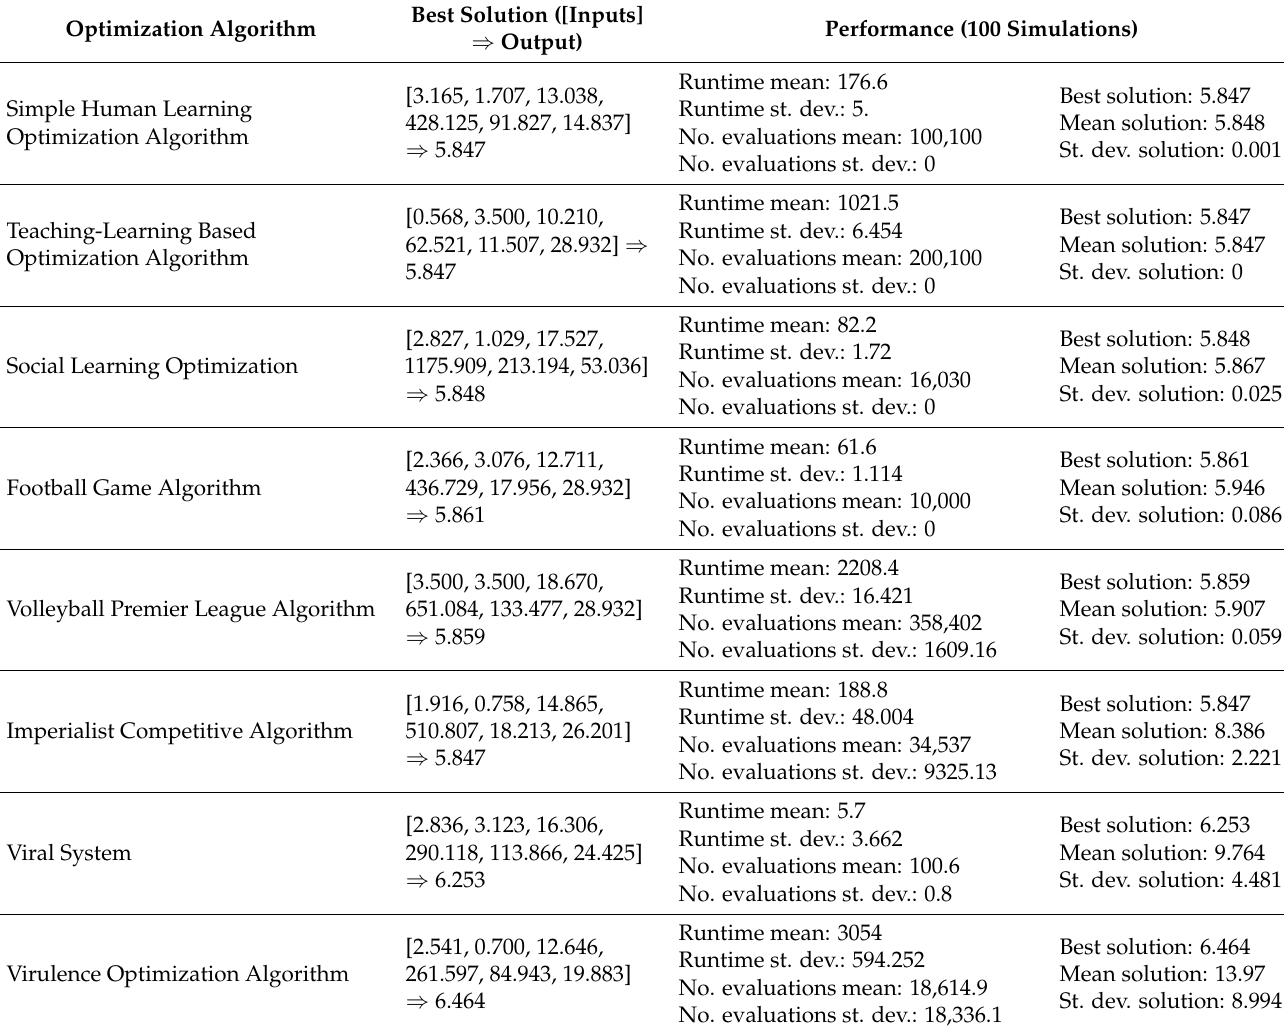
Table 4. Results obtained with biologically inspired optimization algorithms for CH4 (mg/m 3